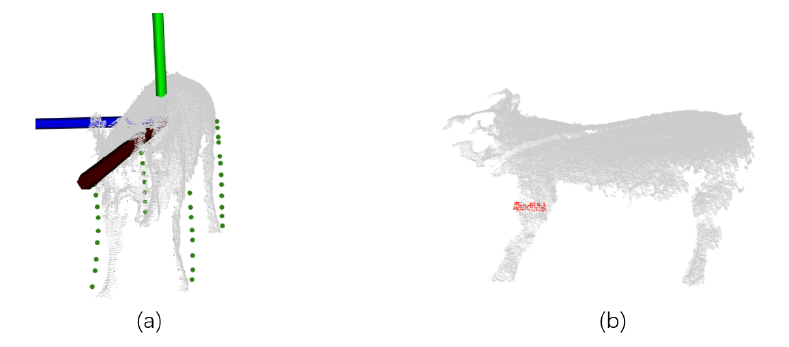
Figure 6. The leg branches moved to the border of the body ( a ) and the banded shape point set ( b ). The skeleton points are labelled in green and the banded shape point set is labelled in